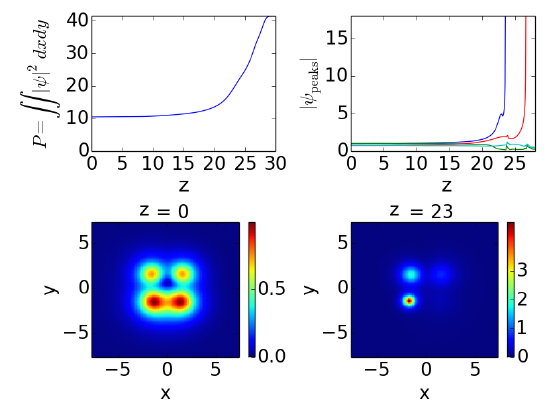
Figure 5. This figure shows the time evolution of the branch 1 solution for the value µ ≈ 0.71. The bottom left plot shows the magnitude of the solution | Ψ | at z = 0. Observe that this solution has four peaks in its magnitude over the two-dimensional spatial grid. The bottom right plot shows the solution at z = 23. Observe that the magnitudes of the peaks on the left side have increased. The top left plot shows the time evolution of the power of the solution as a function of the evolution variable z . The top right plot here shows the evolution of the four peaks in the magnitude of the solution as a function of z (blue = bottom left peak, red = top left peak, green = bottom right peak, cyan = top right